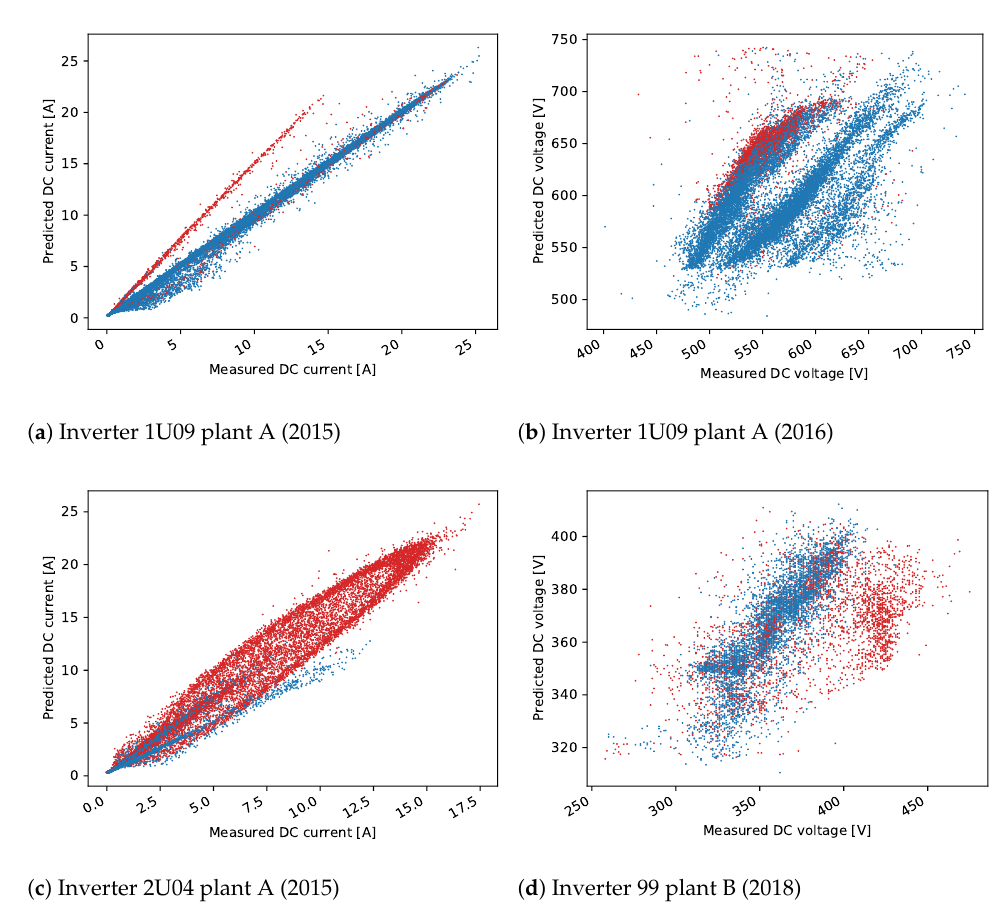
Figure 15. Modeled vs. Predicted values, where the points for the values in the days detected as unusual events are in